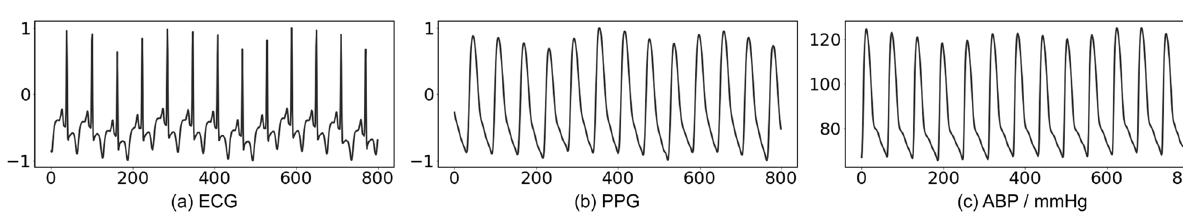
Figure 5. Visualization of the Cuff-less blood pressure estimation dataset. The Electrocardiography (ECG) and Photoplethysmography (PPG) are normalized for better visualization. The Systolic Blood Pressure (SBP) refers to the peak of Arterial Blood Pressure